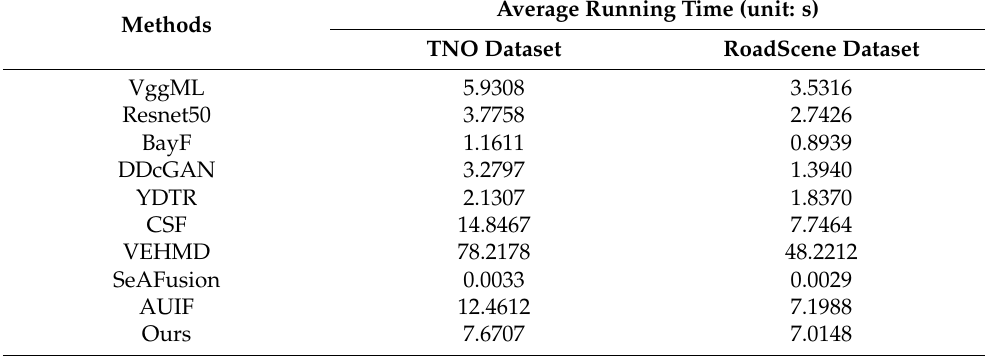
Table 6. Average running time on two public